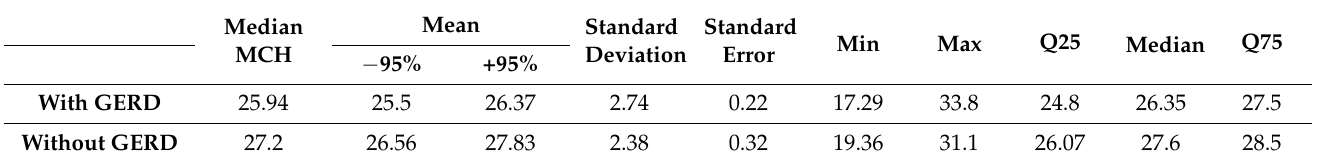
Table 6. Statistical indicators for MCH in relation to GERD.